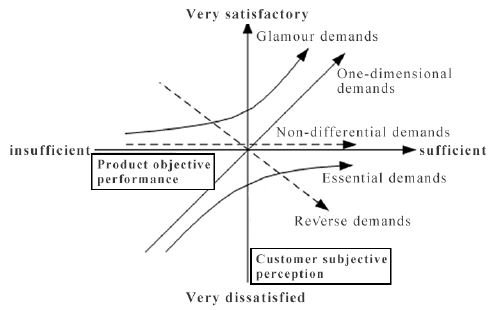
Figure 2. Principle diagram of the Kano demand